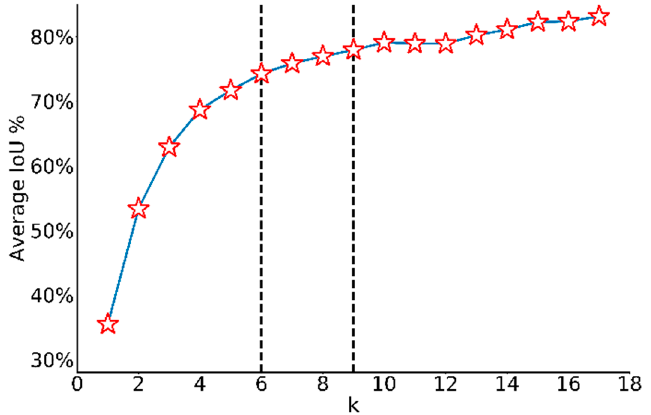
Figure 3. Average IoU under different k values. With k increasing, the average IoU increases.